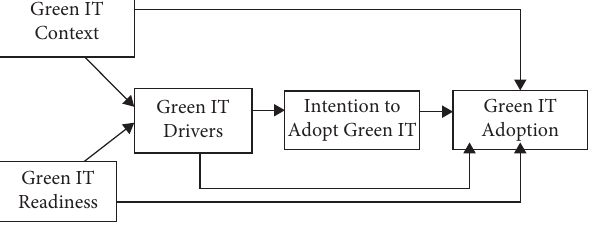
Figure 3: Final model.